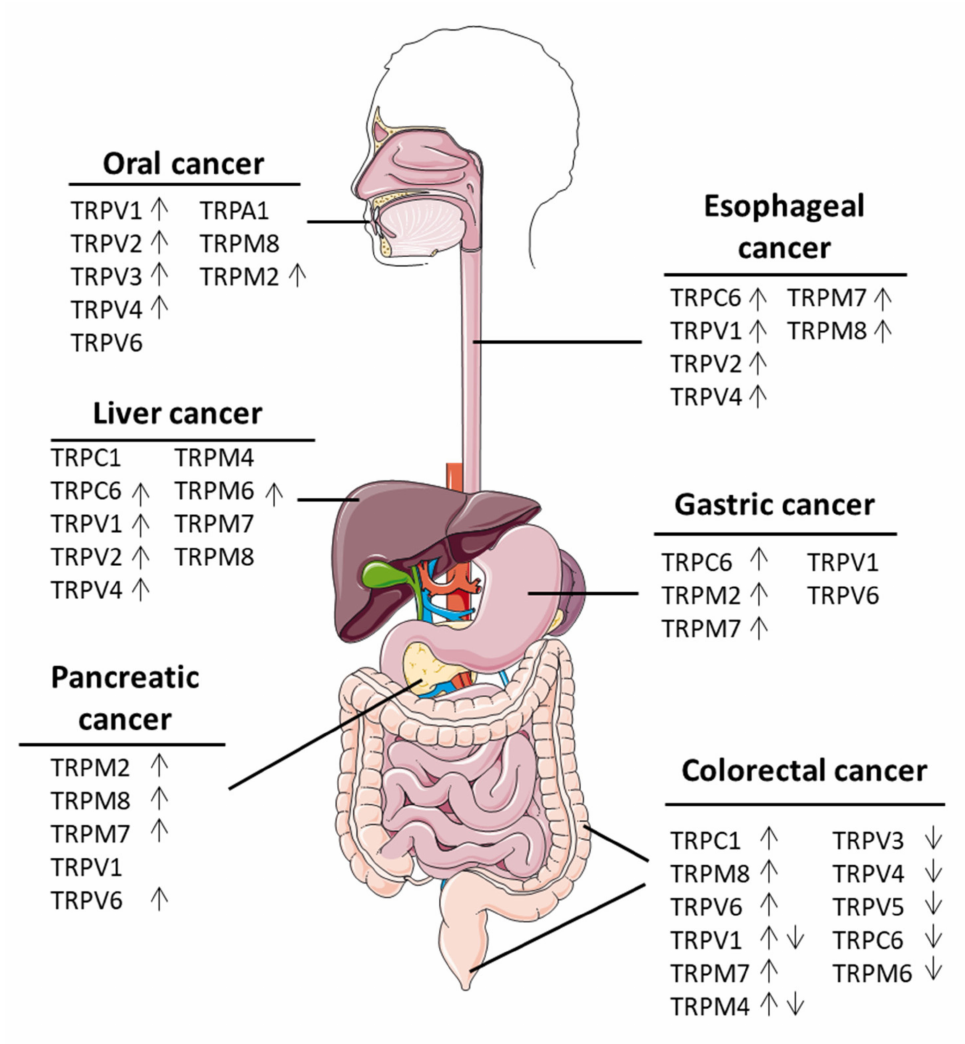
Figure 1. Expression of TRP channels in gastrointestinal tract. Overview of TRP channels expressed in cancers of the gastrointestinal tract or in the cell lines originating from these types of cancers. ↑ Arrows indicates that the channel is upregulated, while ↓ arrows indicates that the channel is downregulated. For some channels, there was more than one study, showing that they are either upregulated or downregulated, which is indicated by ↑↓